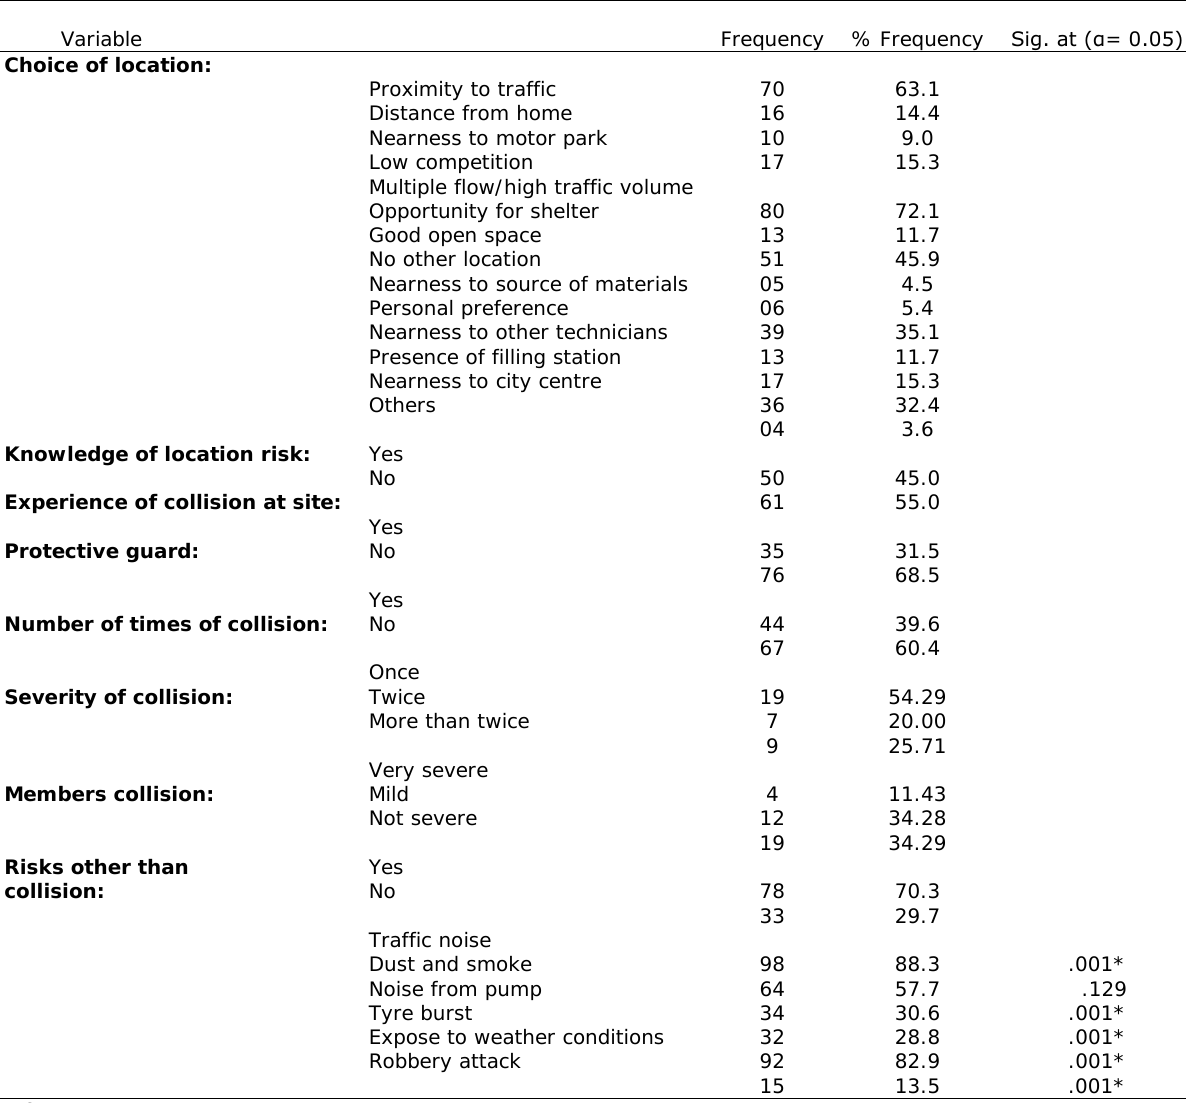
Table 4. Location information